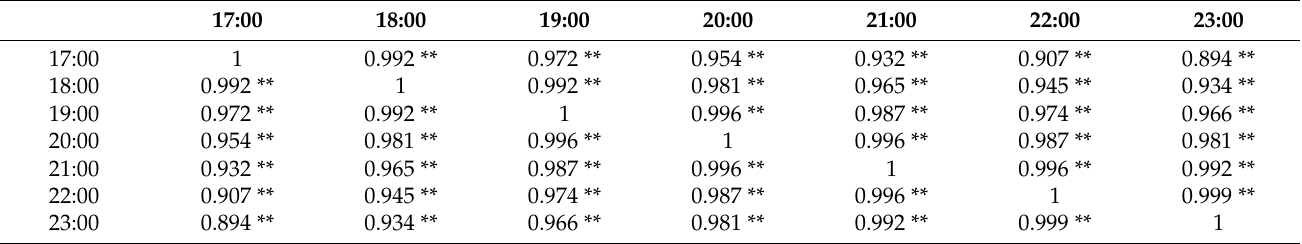
Table A2. Correlation coefficients of vitality between each two times in the nighttime activity period.